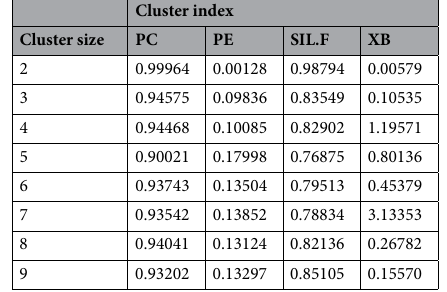
Table 3. PC, PE, SIL.F, and XB values for different cluster size.